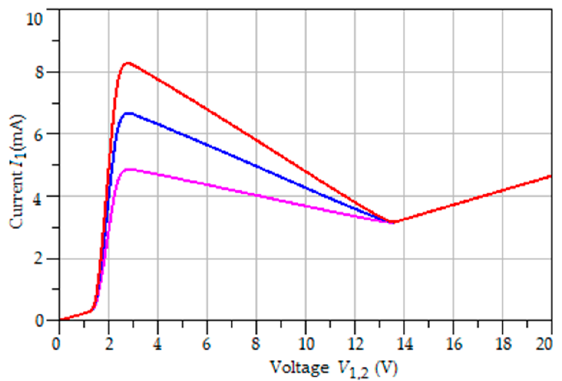
Figure 17. Current-voltage characteristics of the NDR circuit with multiple-output cascode current mirror; m = 0—purple curve, m = 1—blue curve, m = 2—red curve.